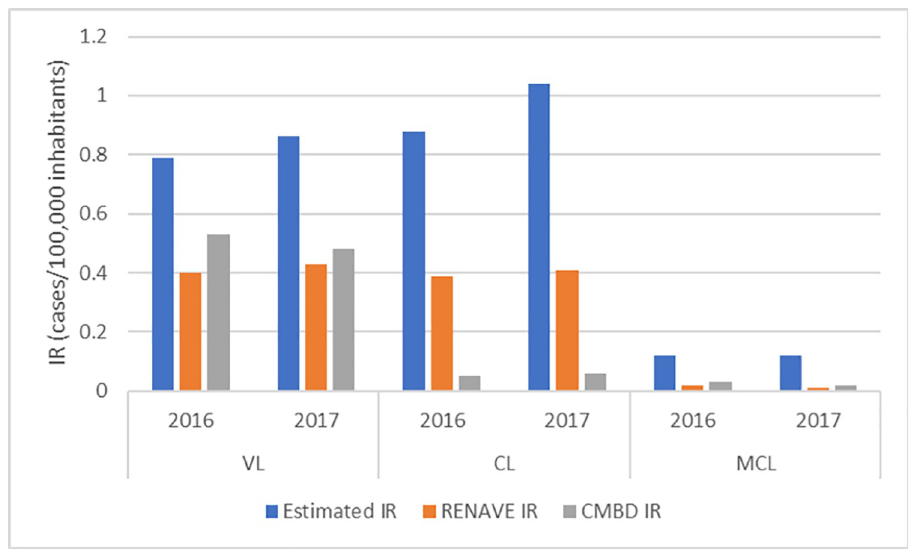
Fig 2. Estimated IR of human leishmaniasis according to the CRC method, Spain, 2016–2017. CL: Cutaneous Leishmaniasis; CMBD: Hospital Discharge Records of the National Health System; CRC: Capture-Recapture; IR: Incidence Rate; MCL: Mucocutaneous Leishmaniasis; VL: Visceral Leishmaniasis; RENAVE: National Surveillance Network.